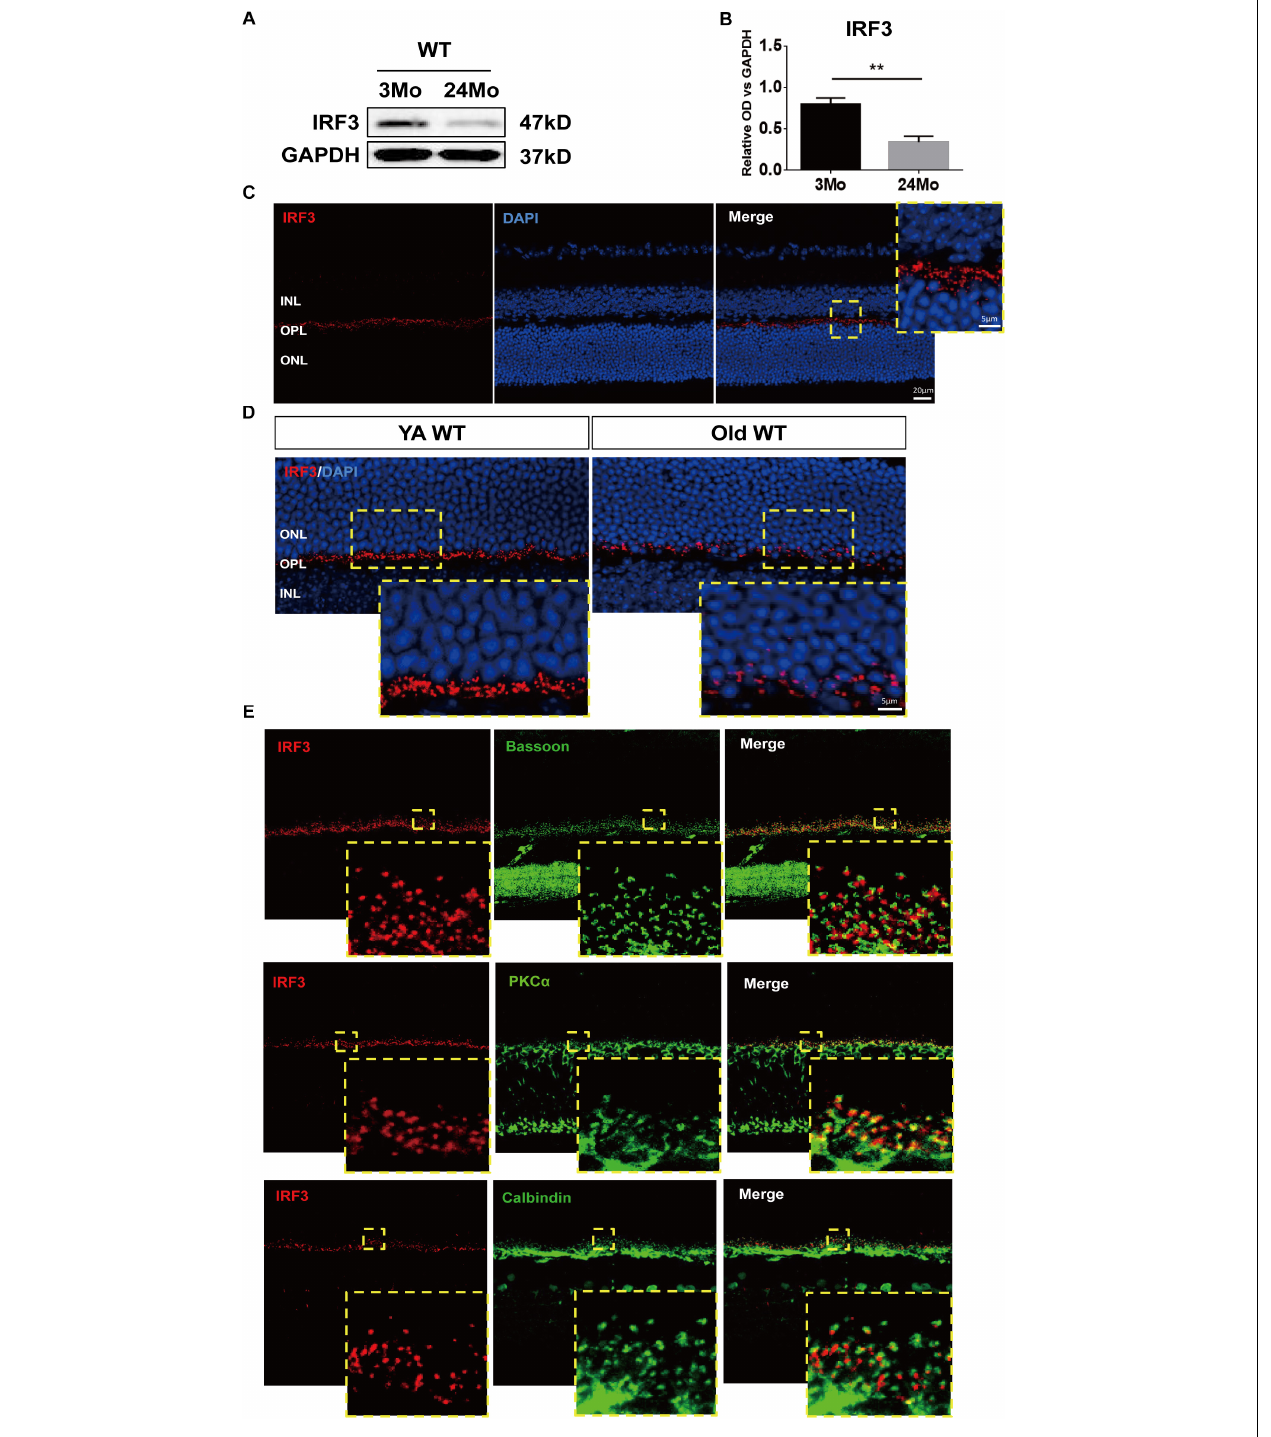
FIGURE 1 | IRF3 is reduced in mouse retina during aging and expressed in the outer plexiform layer (OPL). (A) Representative Western blot band of IRF expression in retina in both YA (young adult, 3–4 months) and Old (22–24 months) WT mice. GAPDH served as the loading control. (B) Quantification of the expression of IRF3 at protein levels in YA and old WT mice. Data are presented as mean ± SEM ( ∗∗ p < 0.01, two-tailed Student’s t -test, n = 5 per group). (C) Immunohistochemical localization of IRF3 (red) in total retina. Scale bars represents 20 µ m. The yellow dotted frame displayed higher-magnification views of the outlined areas (Scale bars represents 5 µ m). (D) The immunofluorescence staining of IRF3 was compared in YA and Old WT mice. Cell nuclei was stained by DAPI. Scale bars = 5 µ m. (E) IRF3 is mainly localized at the dendritic terminal of rod bipolar cells as revealed by co-labeling with Bassoon (presynaptic protein, green), PKC α (rod bipolar cells, green), and Calbindin (horizonal cells,